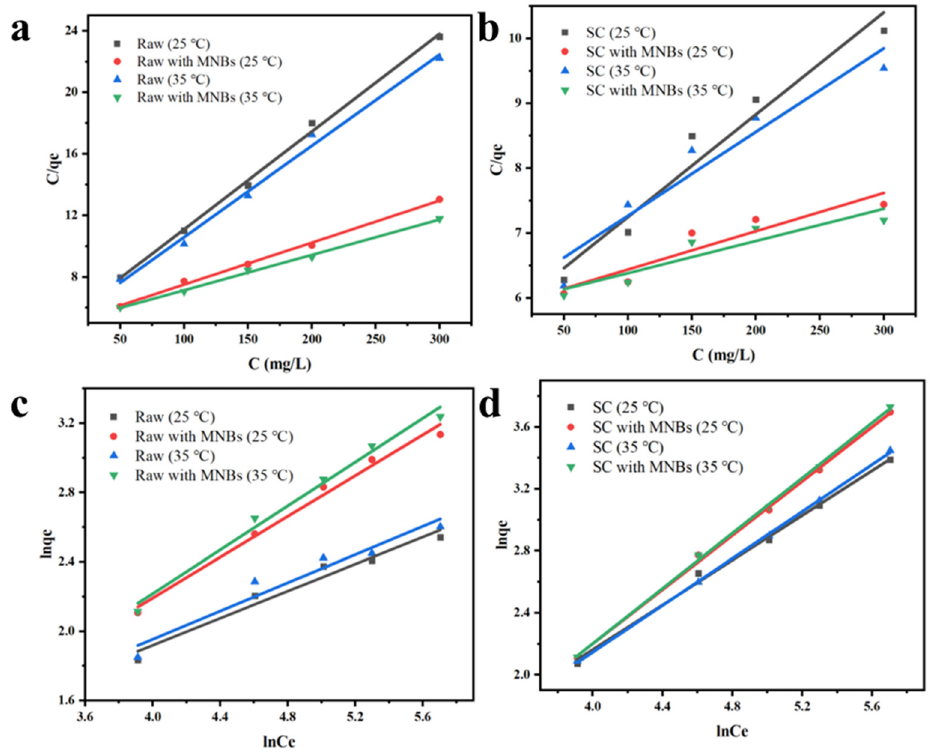
Figure 6. The Langmuir model for raw coal and SC with and without bubbles at different tempera- tures ( a , b ); the Freundlich model for raw coal and SC ( c , d ). Table 2. Langmuir and Freundlich thermodynamic fitting parameters for raw coal, raw coal with MNBs, SC and SC with MNBs.